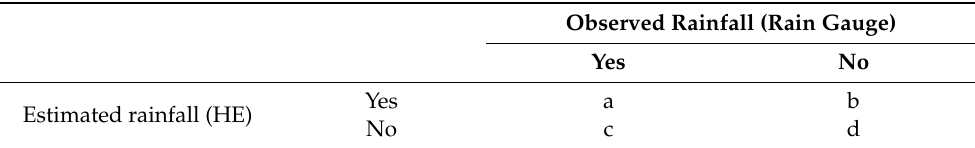
Table 1. Contingency table example to evaluate HE performance at hourly scale. The fields of a, b, c, d represent the total number (N) of data pairs meeting the